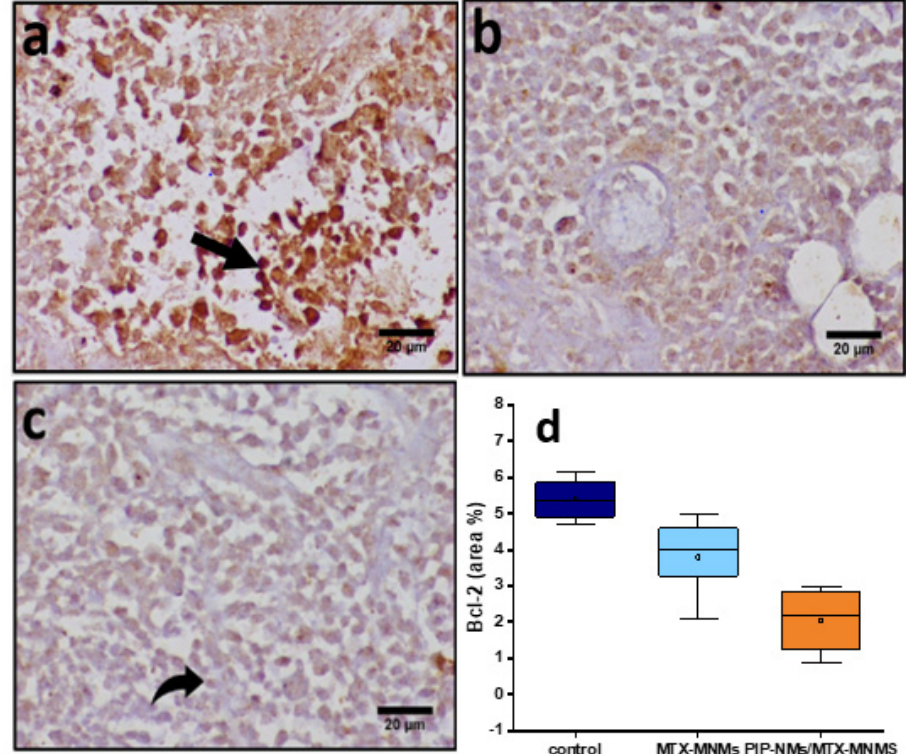
Figure 13. Immunohistochemical staining of Bcl-2 for ( a ) the control group, ( b ) MTX-MNMs-treated group, ( c ) PIP-NMs/MTX-MNMs-treated group, and ( d ) the area (%) of Bcl-2. Straight and curved arrows point to positive expression, and weak expression,